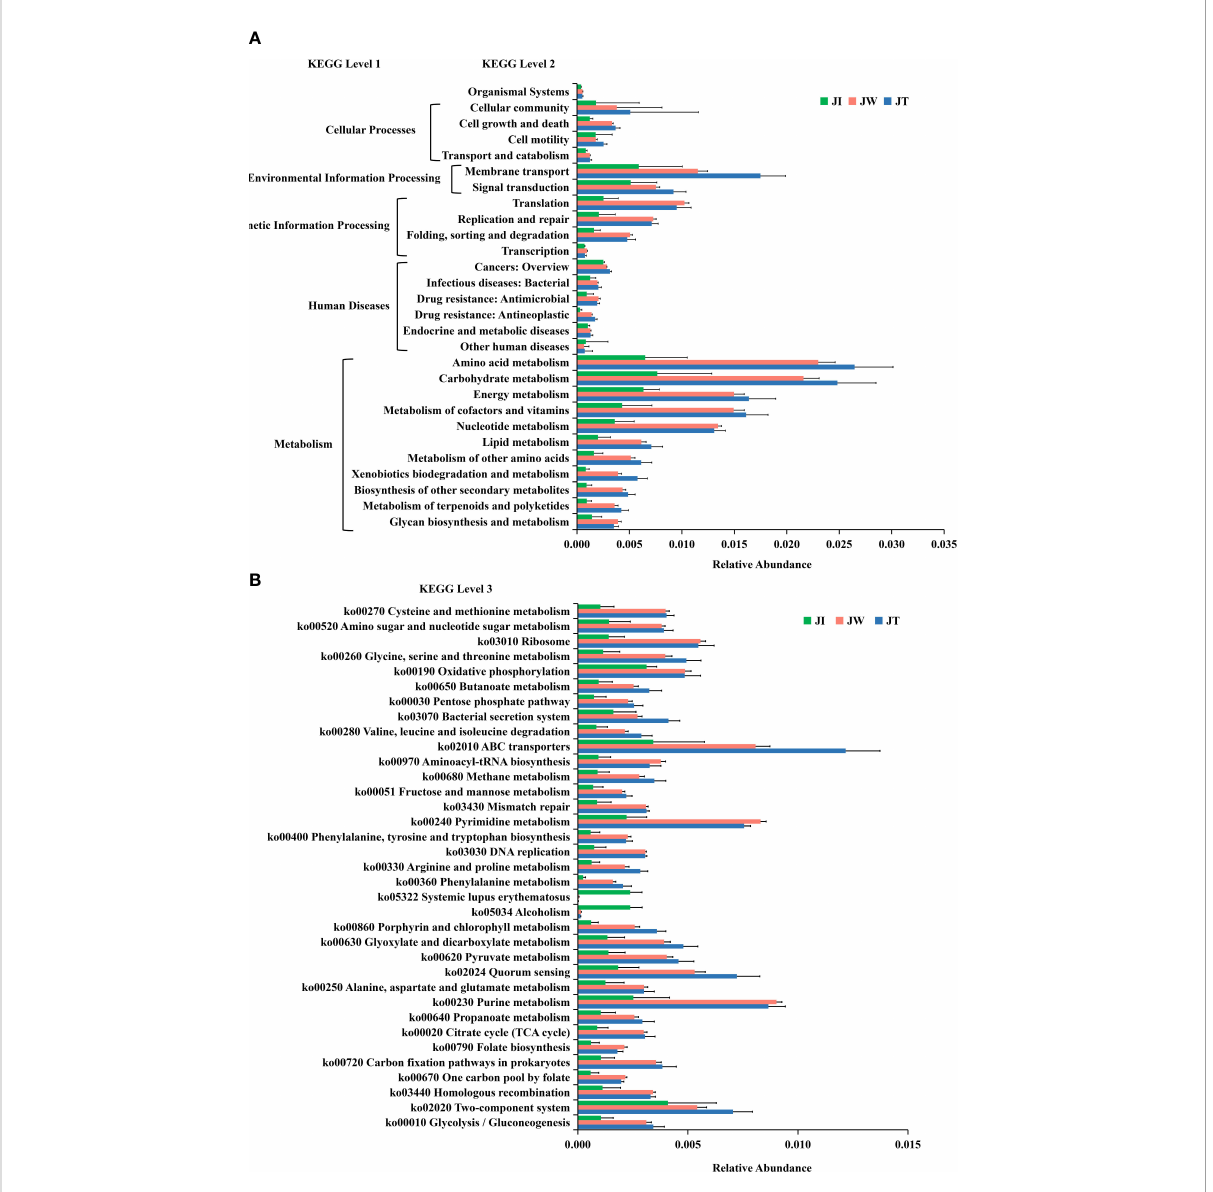
FIGURE 8 Normalised relative abundance of Unigenes of KEGG level 2 (A) and top 35 abundant KEGG level 3 (B) functional categories in JI, JW, and JT. Data are presented as mean ±